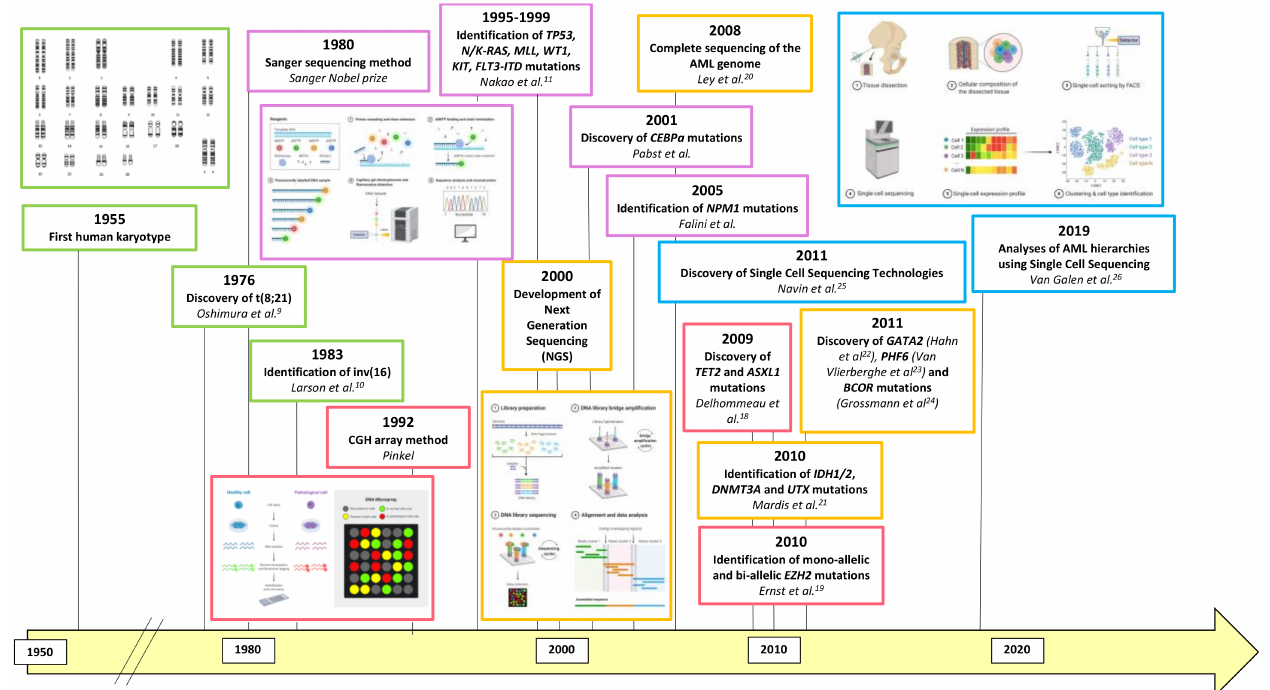
Figure 1. The history of AML genomic discoveries. Green, purple, red, orange and blue represent respectively cytogenetic, Sanger sequencing, CGH array, NGS and Single Cell Sequencing technological discoveries. CGH: Comparative Genomic Hybridization; NGS: Next Generation Sequencing; AML: Acute Myeloid